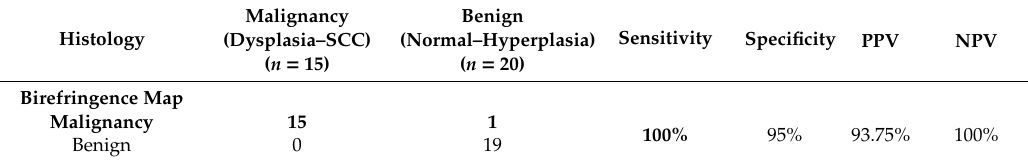
Table 2. Accuracy of en-face birefringence map to detect dysplasia or early cancerous lesion.